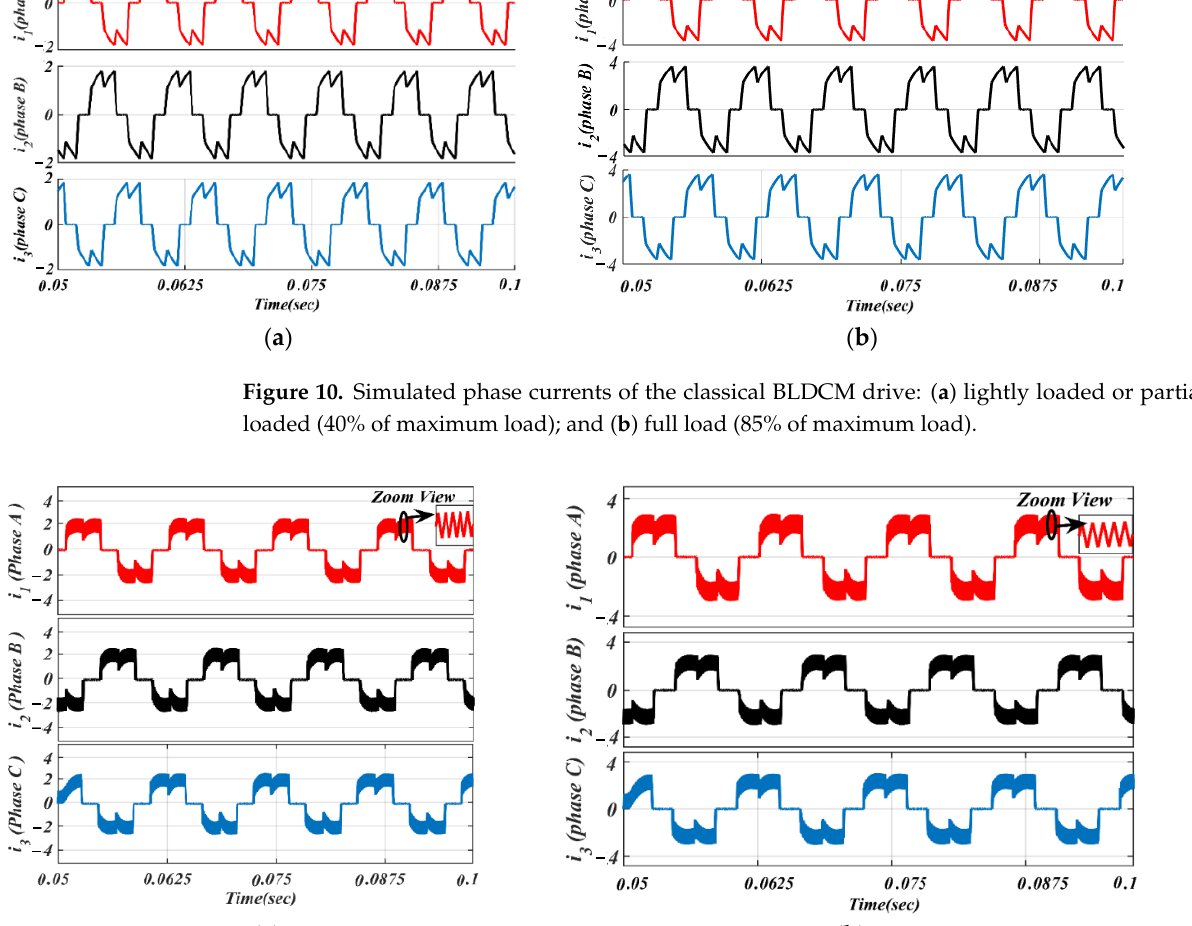
Figure 11. Simulated waveforms of the phase current based on traditional PWM scheme: ( a ) lightly loaded or partially loaded (40% of maximum load); and ( b ) full load (85% of maximum load).